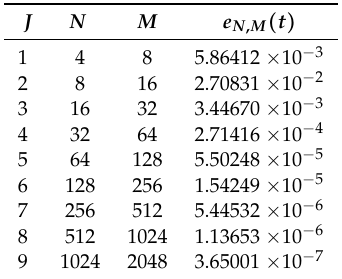
for Example 1. 5